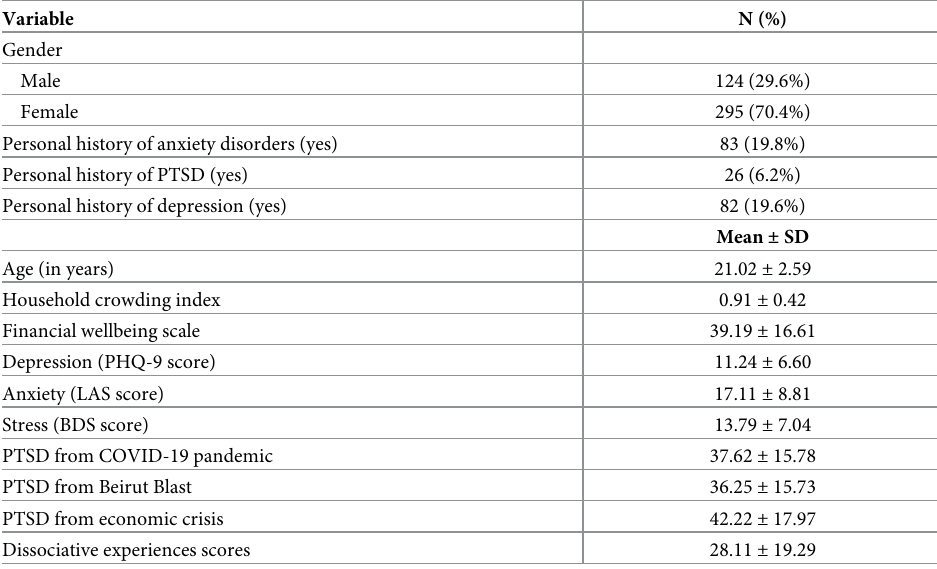
Table 1. Sociodemographic characteristics of the participants (N = 419).